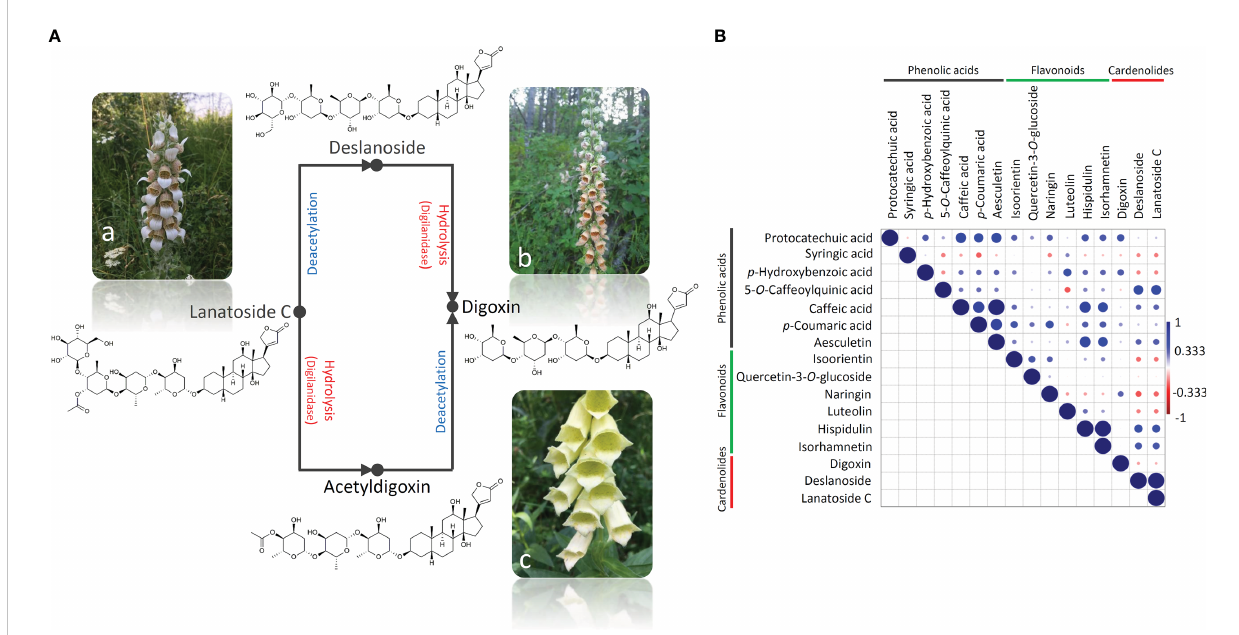
FIGURE 2 A simpli fi ed scheme of the lanatoside C hydrolysis that results in the formation of digoxin in two stages and involves the enzyme digilanidase and one deacetylation step (A) . The conversion goes via either deslanoside (desacetyllanatoside C) or acetyldigoxin. D. lanata (a) is a rich source of lanatoside C, D. ferruginea (b) contains predominantly deslanoside and digoxin, while D. grandi fl ora (c) is abundant in digoxin. Correlation analysis of the compounds ’ quantitative data was performed (B) , and the correlation matrix was constructed using Pearson ’ s correlation algorithm. Color scale indicates a positive (blue) or a negative (red) correlation.